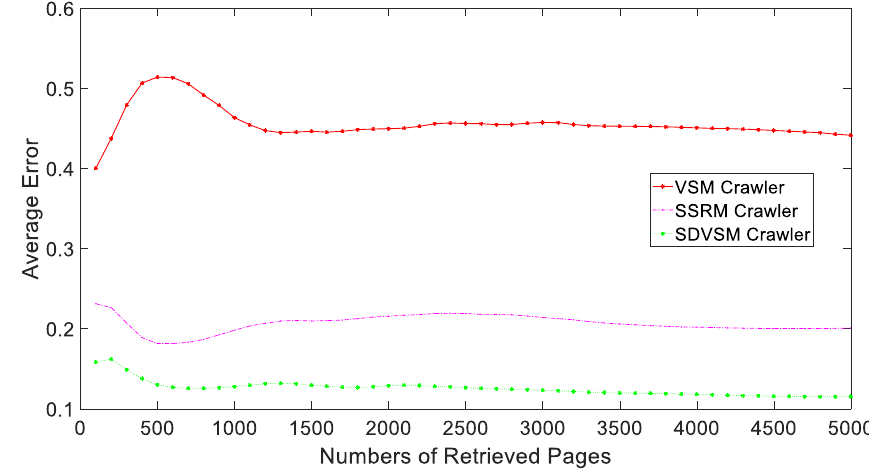
Fig. 15 The comparison of the average error for three focused crawlers based on the third group